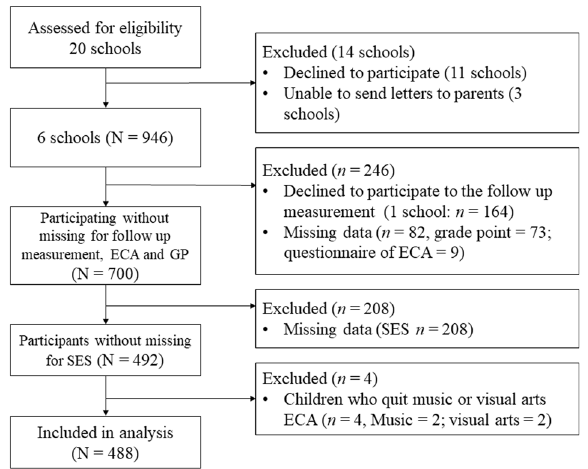
Fig. 4 Flow diagram of the recruitment of children and missing data. ECA extracurricular